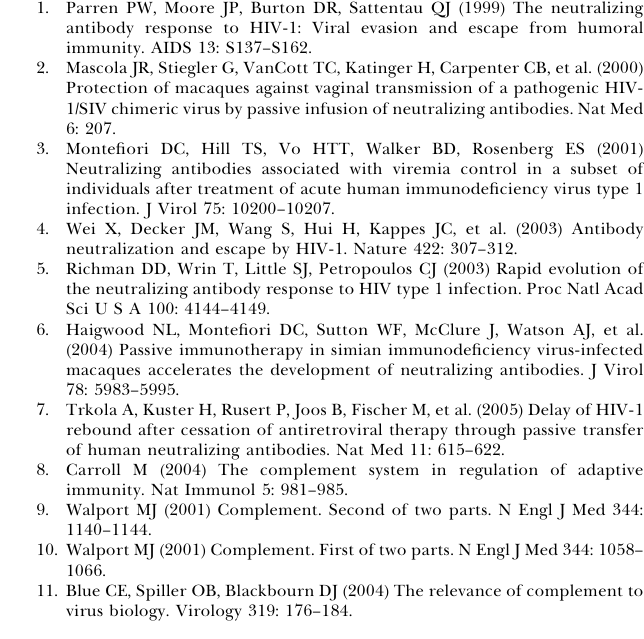
Figure S1. The Extent of Lysis Is Independent of the Amount of Virus Input The varying amounts of RNA input into the autologous assays were correlated with measured autologous virolysis activities. Correlation was evaluated using Spearman’s rank correlation ( n ¼ 56, rho ¼(cid:1) 0.09, p ¼ 0.53, two-tailed). Found at doi:10.1371/journal.pmed.0030441.sg001 (841 KB DOC). Table S1. Control Group Demographics Found at doi:10.1371/journal.pmed.0030441.st001 (35 KB